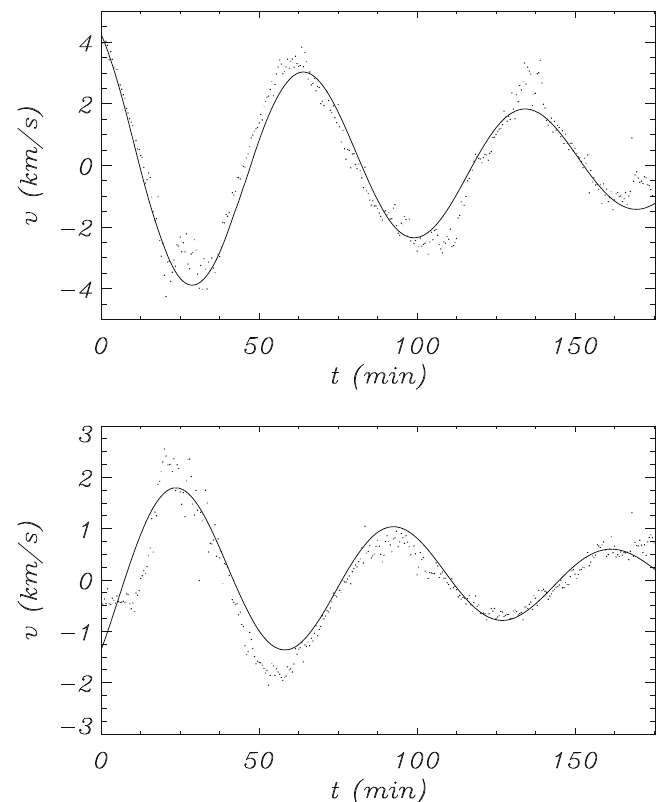
Fig. 16 Observed Doppler velocity (dots) and fitted function (continuous line) versus time at two different points in a quiescent prominence. The period is 70 min in both points and the damping time is 140 and 101 min, respectively. The function fitted to the observational data is of the form v 0 cos (ω t + φ) exp ( − t /τ) . Adapted from Molowny-Horas et al.